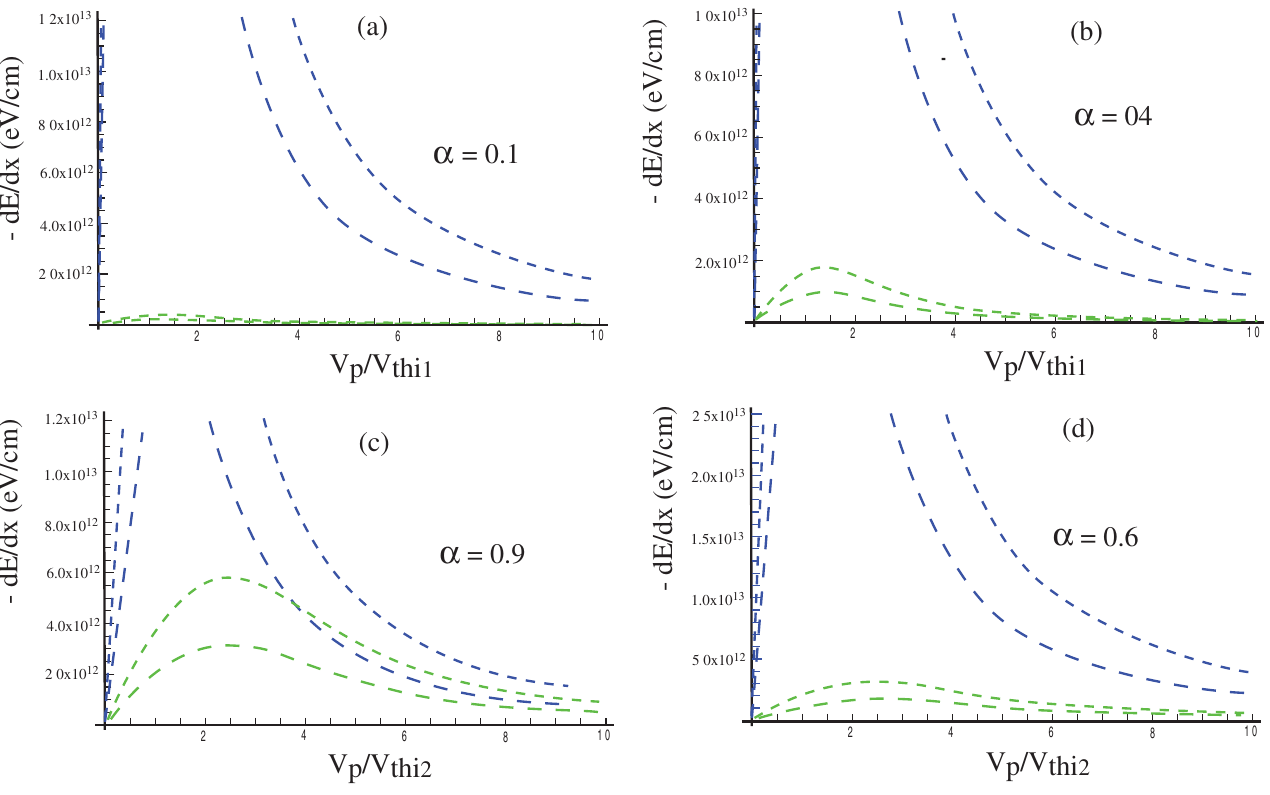
FIG. 9. (Color) Alpha particle projectile in a Si 14 þ - Sr 36 þ BIM with a n e ¼ 10 26 e cm (cid:1) 3 and temperatures ¼ ( ) 100 keV, ( ) 200 keV with Si 14 þ relative proportion: (a) (cid:1) ¼ 0 : 1 , (b) (cid:1) ¼ 0 : 4 , (c) (cid:1) ¼ 0 : 9 , and (d) (cid:1) ¼ 0 : 6 . Dark gray (red) refers to electron stopping, light gray (green) to D þ stopping, and black (blue) denotes T þ stopping, (cid:1) dE=dx ( eV = cm ) in terms of V p =V thi